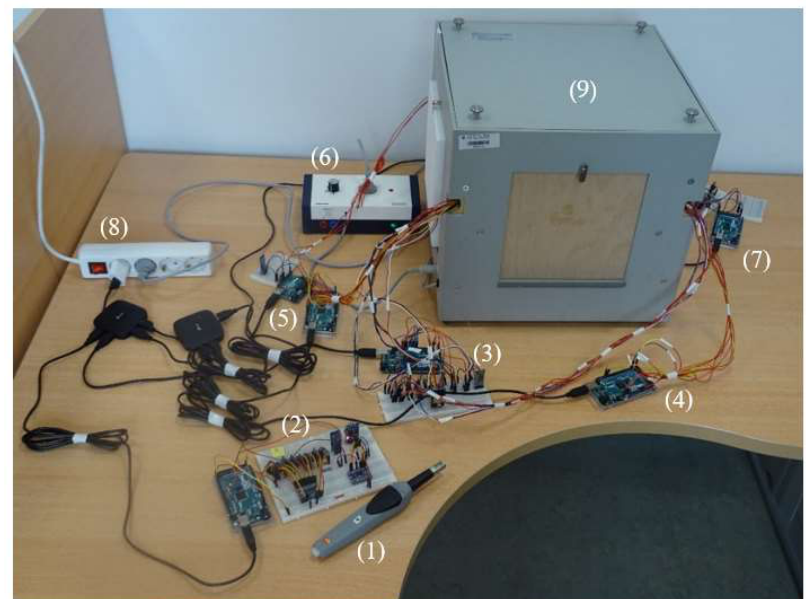
Figure 9. The developed sensors and test condition: (1) outdoor probe of TESTO 435-1 ( T e ), (2) outdoor module sensor SHT35 ( T e ), (3) sensor DS18B20, (4) sensor MLX90614, (5) sensors for controlling the indoor/outdoor temperature, (6) thermostat, (7) sensor MAX30205, (8) power source, and (9) the temperature-controlled box model.